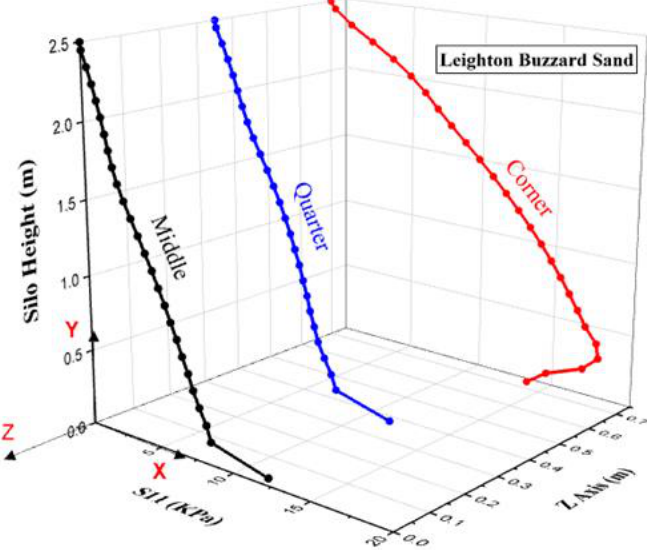
Figure 11. 3-D lateral wall pressure in squat flexible wall silo filled with sand.